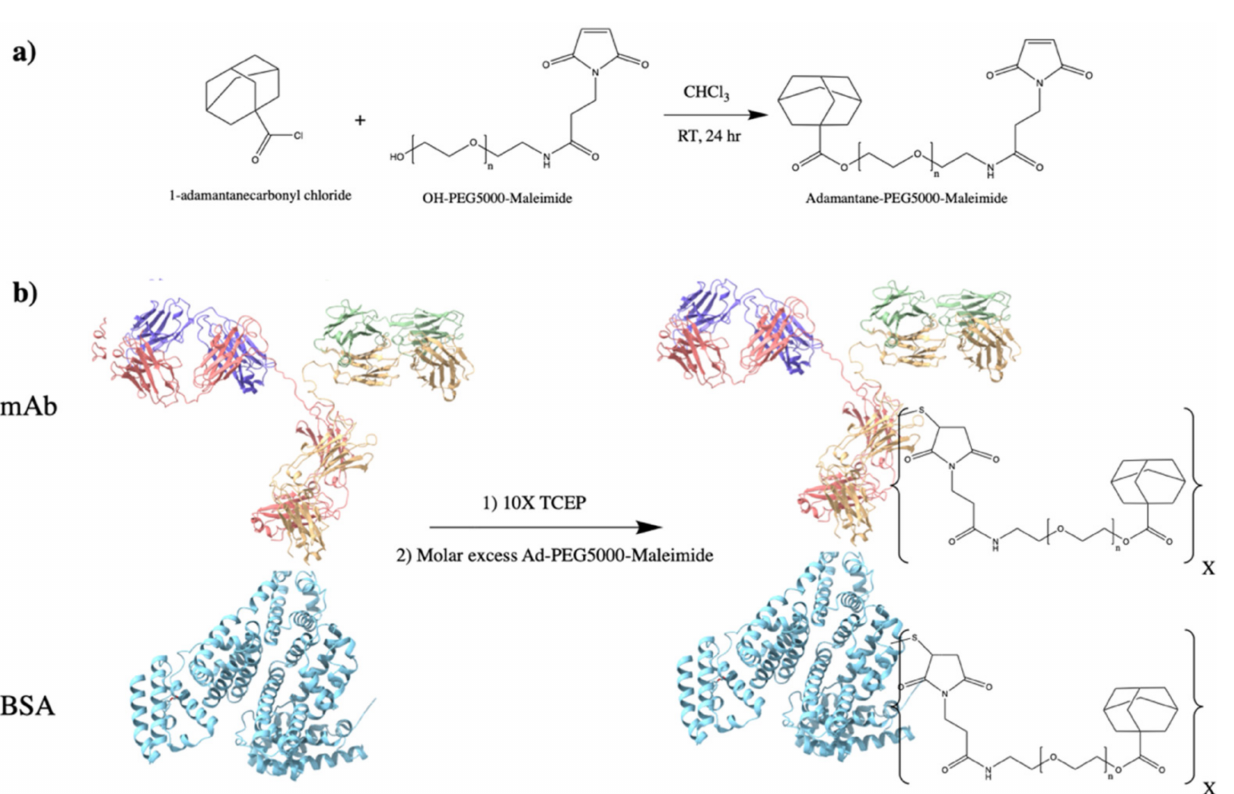
Figure 2. Synthesis overview for protein–PEG–Ad conjugates: ( a ) synthesis of Ad–PEG 5000 –Mal, a nucleophilic addition/elimination reaction; and ( b ) synthesis of protein–(PEG 5000 –Ad) x where X represents the number of PEG 5000 –Ad “tethers” conjugated to each molecule of protein. BSA (PDB entry 4F5S) is used as a model protein, mAb (PDB entry 1IGT) is used as a “functional example” of an antibody therapeutic. Products for mAb synthesis in ( b ) will also produce two fragmented antibodies